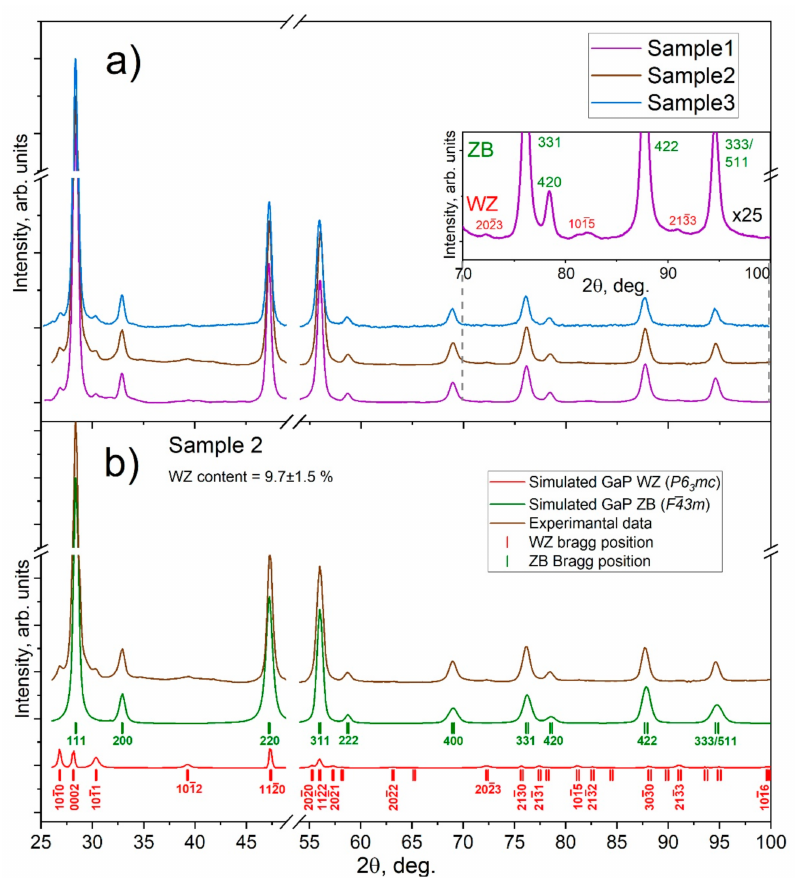
Figure 6. ( a ) X-ray powder diffraction patterns of GaP NW embedded in scotch adhesive, inset— zoomed area of XRD pattern, ( b ) XRD patterns of Sample 2, where: the red line is the profile of simulated XRD pattern for GaP WZ space group, the green line is a simulated profile of ZB XRD pattern and the brown line is experimental data after background subtraction, offset for